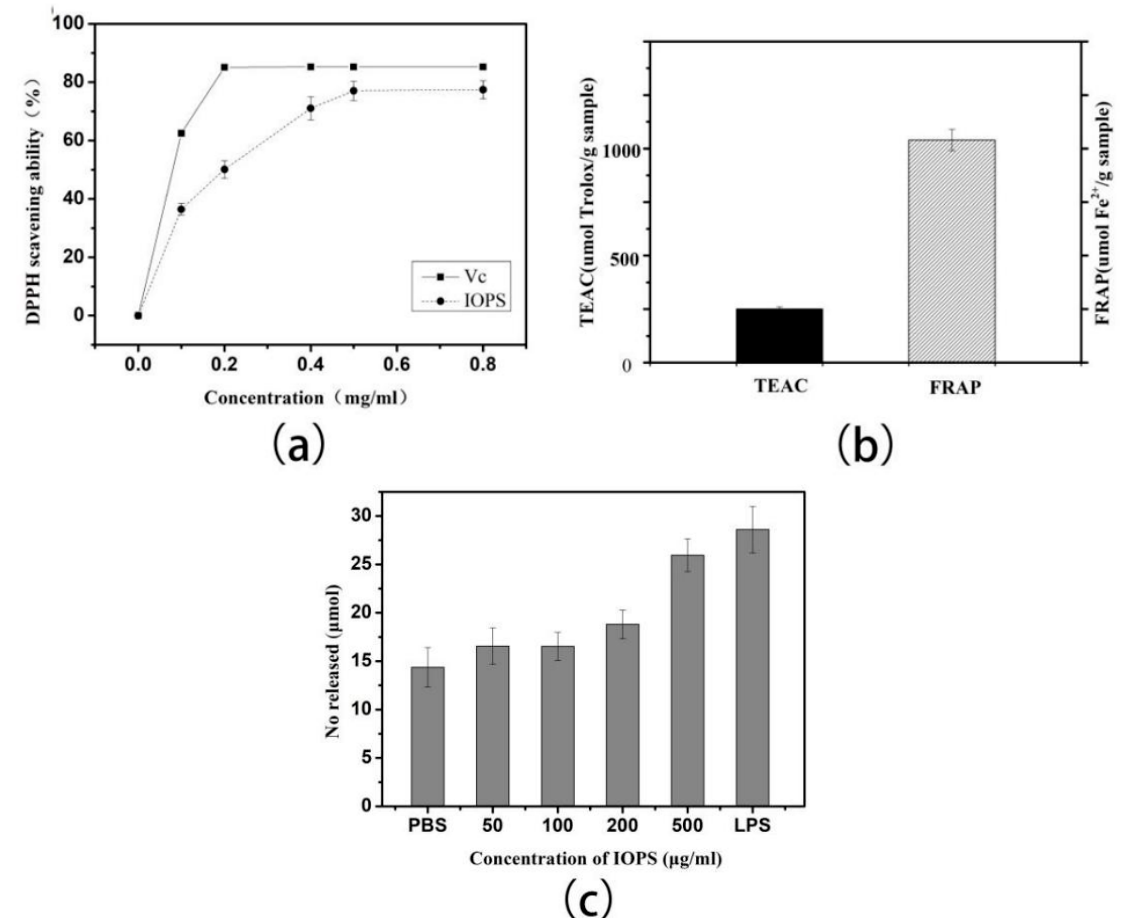
Figure 4. Physicochemical properties of the purified IOPS analyzed by ( a ) HPSEC-MALLS-RI chromatograms and ( b ) FT-IR spectrum.